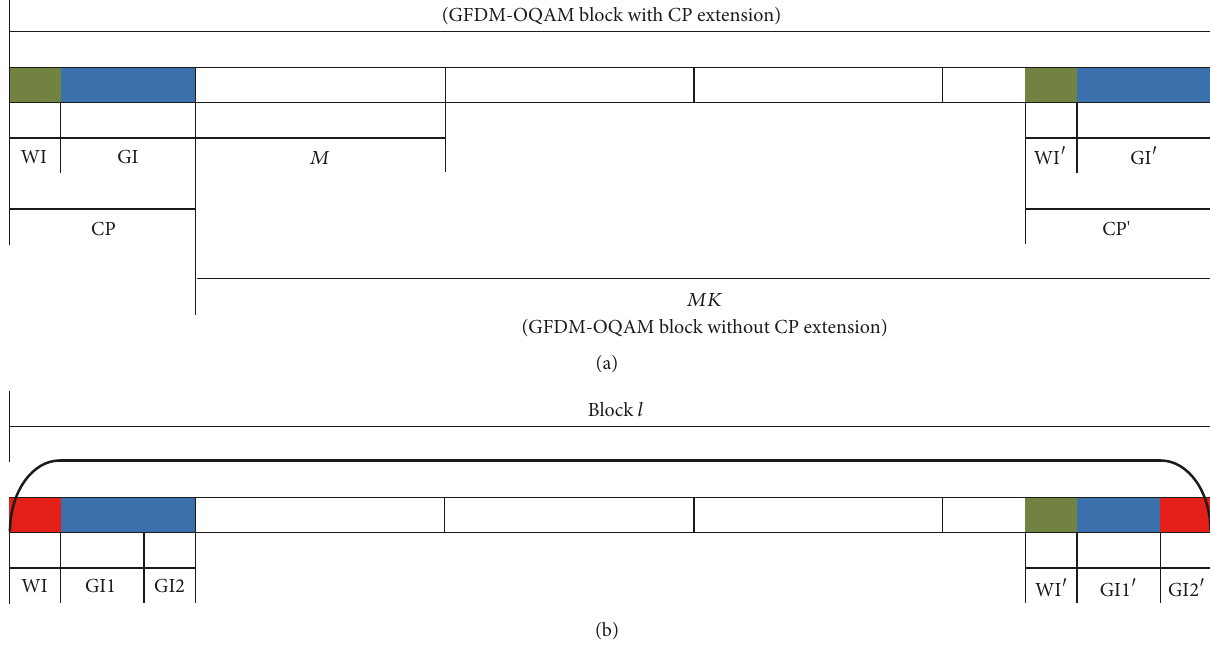
Figure 8: Windowing operation of a WCP-COQAM block. (a) A WCP-COQAM block before windowing is equal to a GFDM-OQAM block with CP extension. (b) The first and the last 𝐿 WI samples of a WCP-COQAM block are distorted by the window.